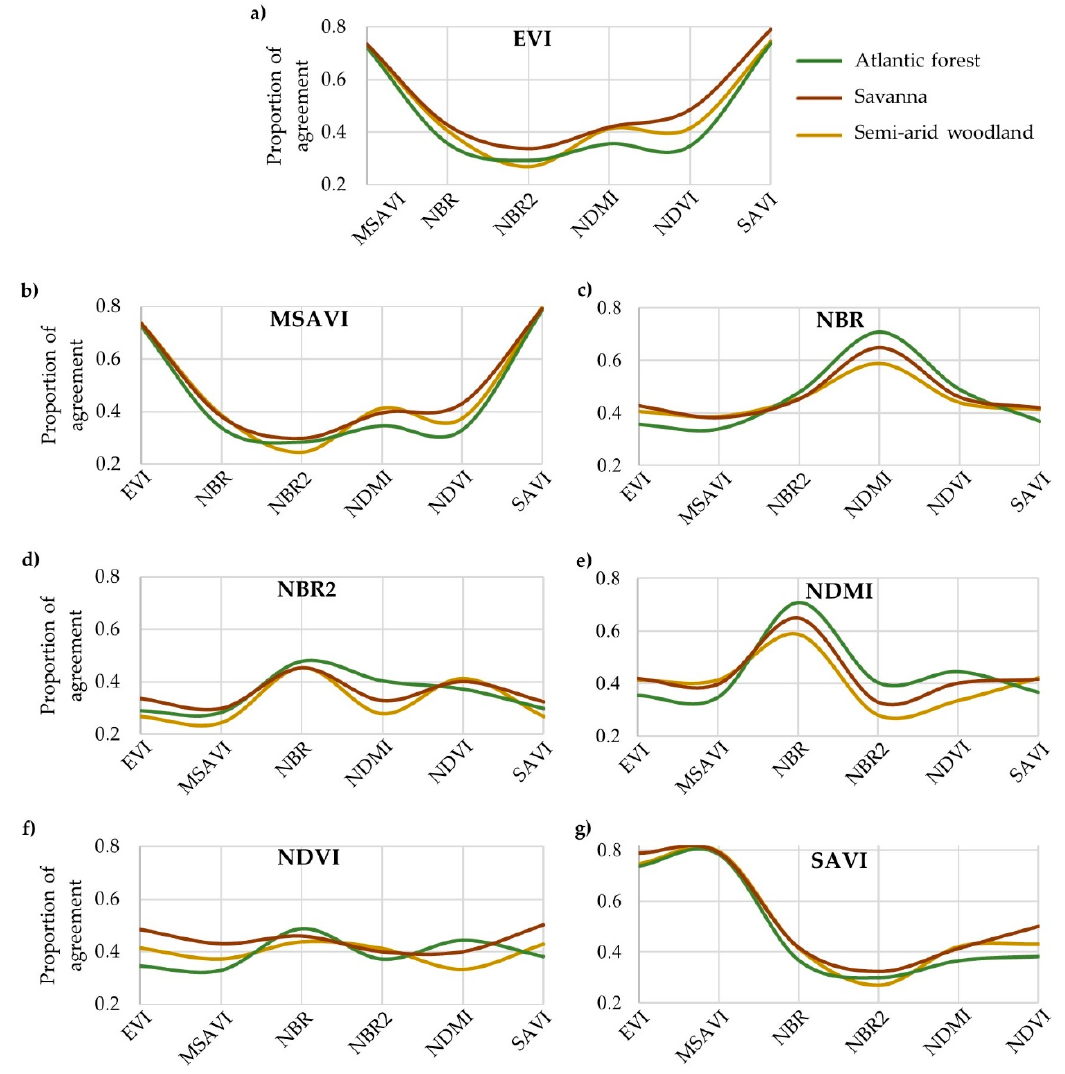
Figure 4. Paired spatial agreement in detected disturbance between the seven spectral index disturbance maps. Individual spatial relationships are represented by ( a ) EVI, ( b ) MSAVI, ( c ) NBR, ( d ) NBR2, ( e ) NDMI, ( f ) NDVI, and ( g ) SAVI. Proportions of agreement varied from 0 (total disagreement) to 1 (total agreement) between indices.